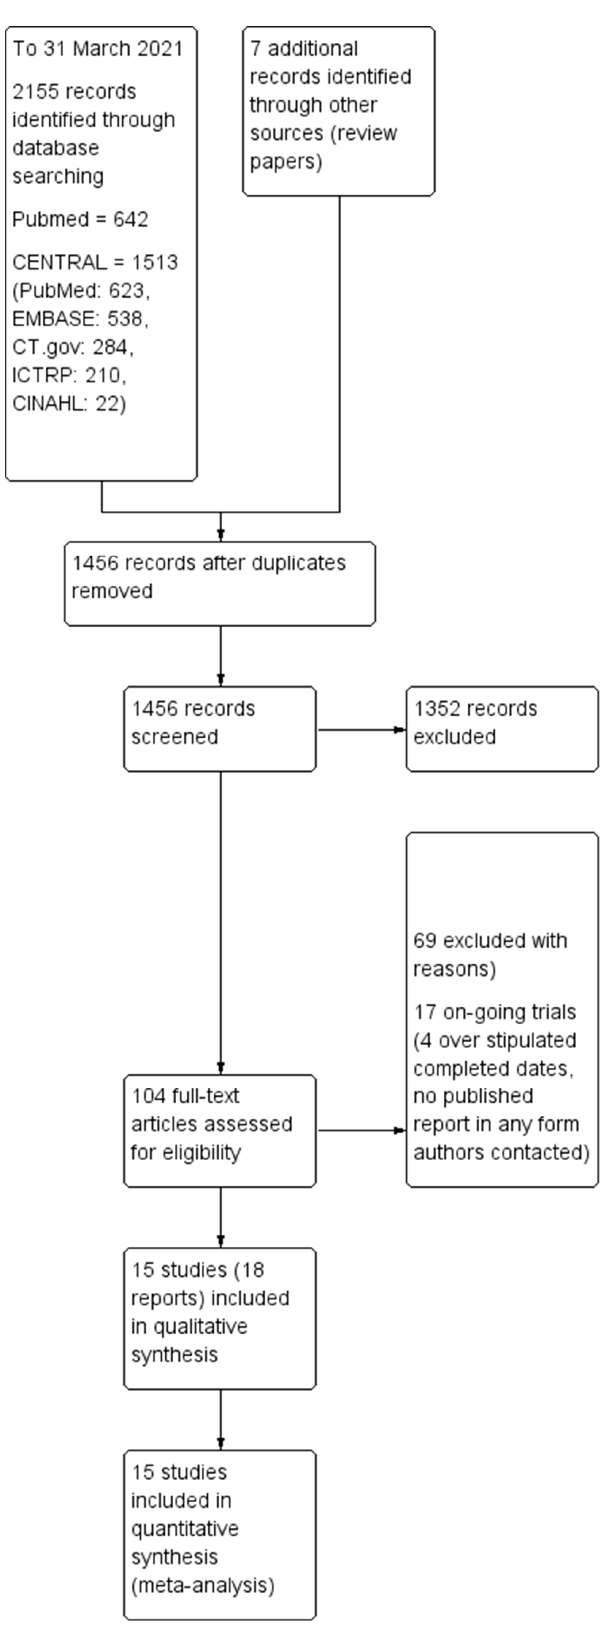
Figure 1. Preferred reporting items for systematic reviews and meta-analyses (PRISMA) flowchart that shows study flow in the review work to investigate the benefits of